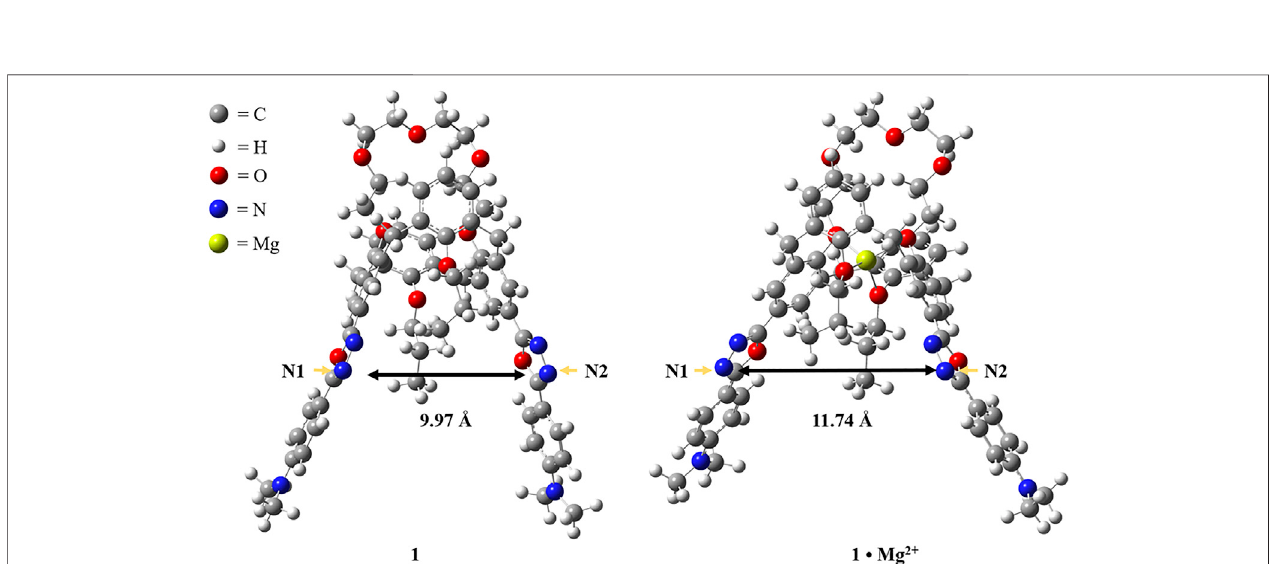
FIGURE 7 | Computational optimized molecular structures of 1 and 1 · Mg 2 +